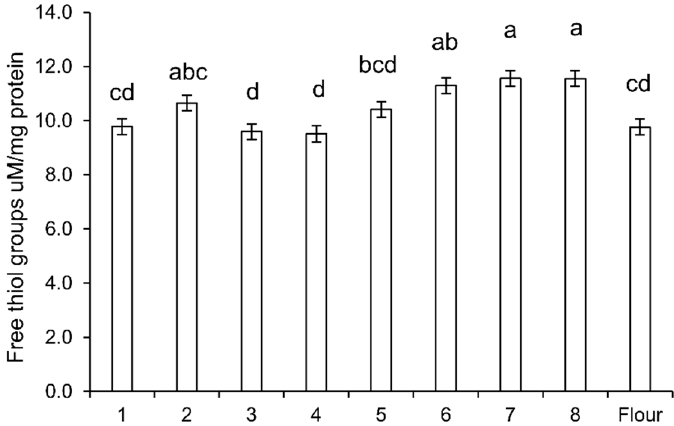
Figure 4. Free thiol groups in the albumin / globulin extracts of doughs. The number indicates the dough systems described in Figure 1. Dough 1, yeast-fermented dough at 30 ◦ C for 1 h; 2, yeast-fermented dough at 30 ◦ C for 17 h; 3, yeast-fermented dough at 4 ◦ C for 17 h; 4, yeast-fermented dough with glutathione at 30 ◦ C for 1 h; 5, yeast-fermented dough with glutathione at 30 ◦ C for 17 h; 6, chemically acidified dough, pH 3.5, at 30 ◦ C for 17 h; 7, wheat sourdough at 30 ◦ C for 17 h; 8, chemically acidified dough, pH 3.5, with glutathione at 30 ◦ C for 17 h; F, wheat flour. Bars that do not share a common superscript di ff er significantly ( p < 0.05, one-way ANOVA with Tukey’s honest significance test (HSD) analysis).